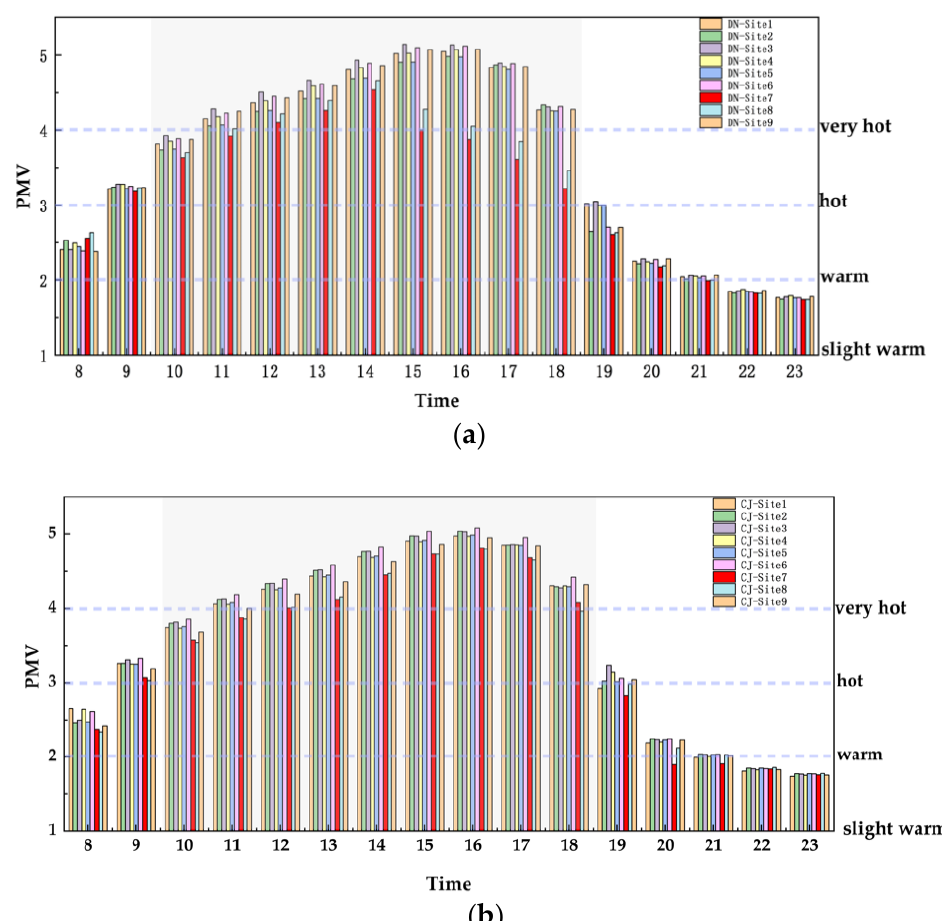
Figure 10. PMV histograms of the villages from 8:00 to 23:00 on 21 July 2018: ( a ) DN village, ( b ) CJ village.